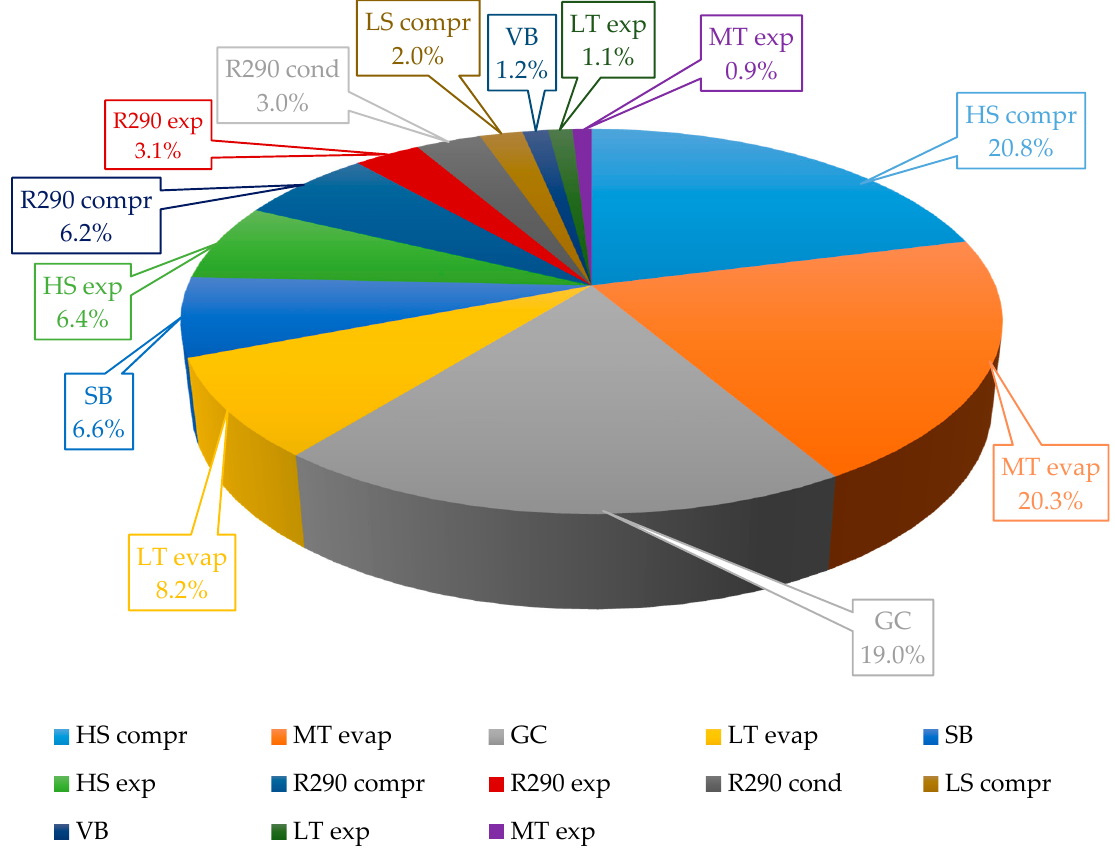
Figure 4. Breakdown of the contribution (%) of each component belonging to DMS to the total exergy destruction rate at the outdoor temperature of 40 °C. Table 8. Results related to the advanced exergy analysis for DMS at the outdoor temperature of 40 °C. Component